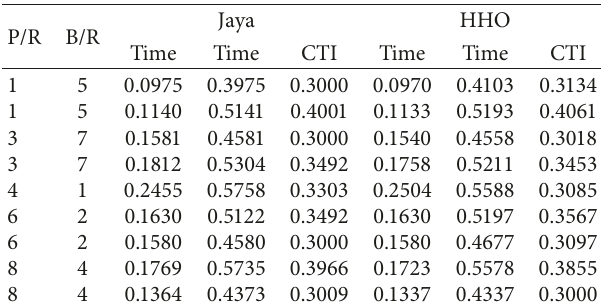
Figure 18: Independent runs for the 4-bus system by NLP formulation. Table 20: Operating time and CTI for the 4-bus system by NLP